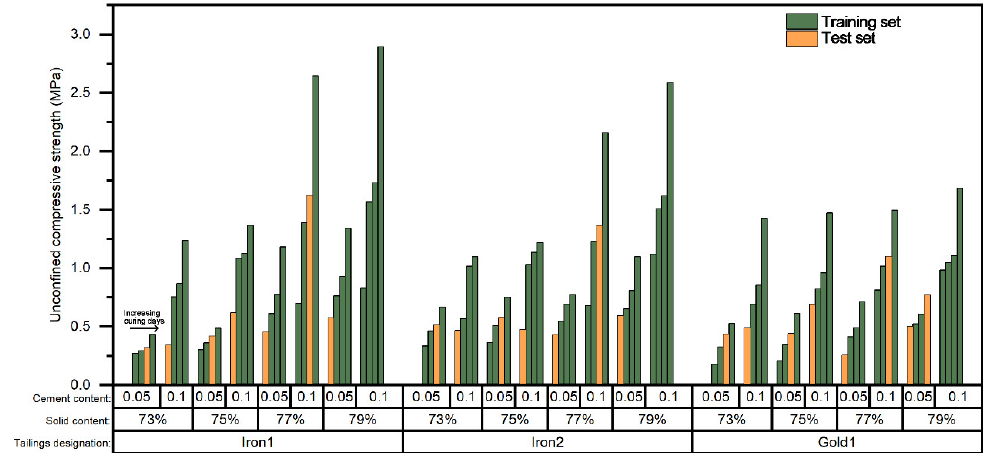
Figure 8. The specific data distribution of the training set and test set based on the categorized randomly segmented dataset.